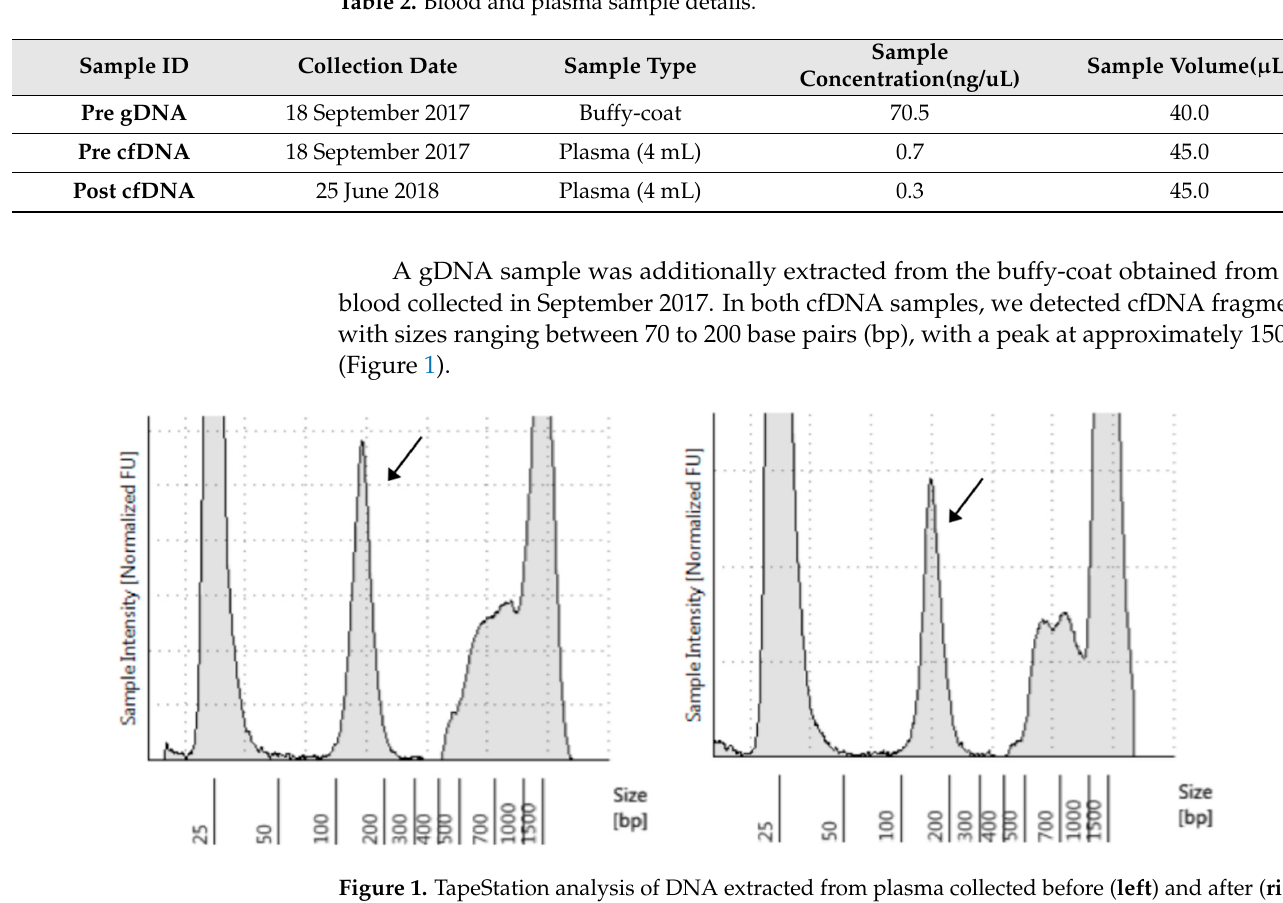
Table 2. Blood and plasma sample details.